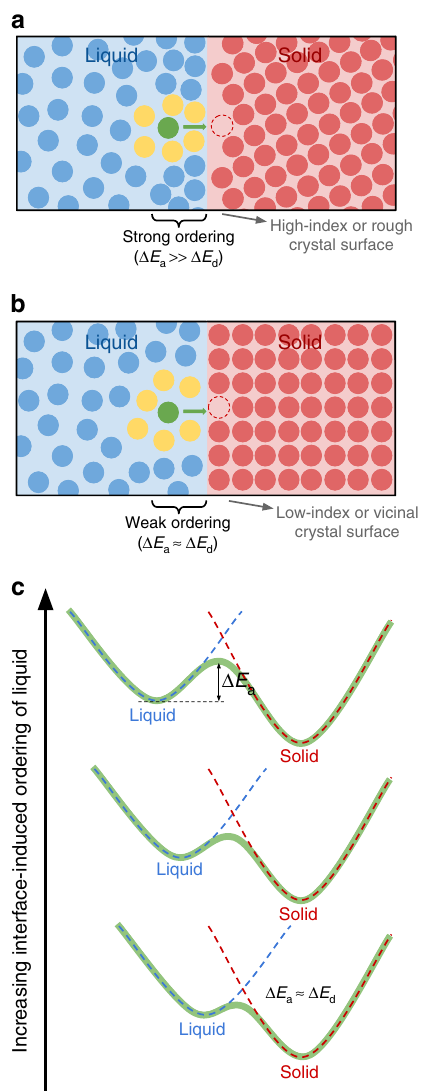
Fig. 8 Interface-induced ordering mechanism. a Illustration of how interface-induced ordering of the liquid alters the local structure around crystallizing atoms and affects the activation energy for solidi fi cation. The crystallizing atom (green) has its local structure (illustrated here only by its fi rst neighbors) affected by the nearby solid – liquid interface. This effect is anisotropic: high-index or rough interfaces interact strongly with the liquid and cause signi fi cant ordering of the liquid, which becomes rigid, resulting in large activation energies Δ E a when compared to the barrier for diffusion in the liquid Δ E d . b Low-index interfaces interact weakly with the liquid and cause very small ordering, resulting in low Δ E a . c Schematic illustration of the effect of interface-induced ordering of the liquid on the free-energy landscape of crystallization. Note how the liquid free-energy basin moves to the left with increasing ordering, causing Δ E a to become progressively and continuously